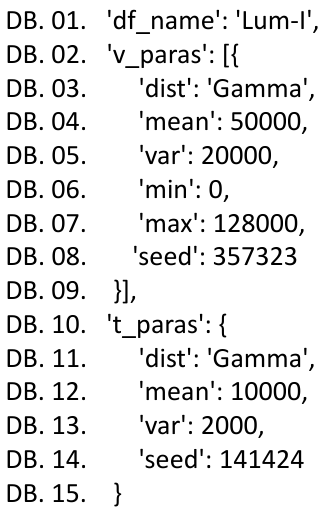
Figure A8. The Lum-I parameter record